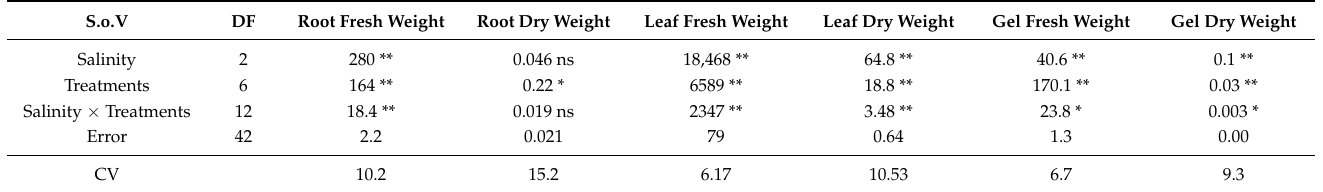
Table 1. ANOVA for the effects of salinity stress (0, 50, and 100 mM NaCl) and foliar applications (without spraying, potassium nitrate, ZnO, and Fe nanoparticles) on some growth-related traits and gel content of Aloe vera plants.